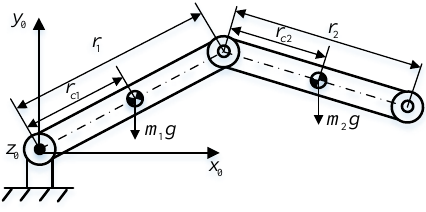
Figure 2. Link model of the 2-DOF planar manipulator.